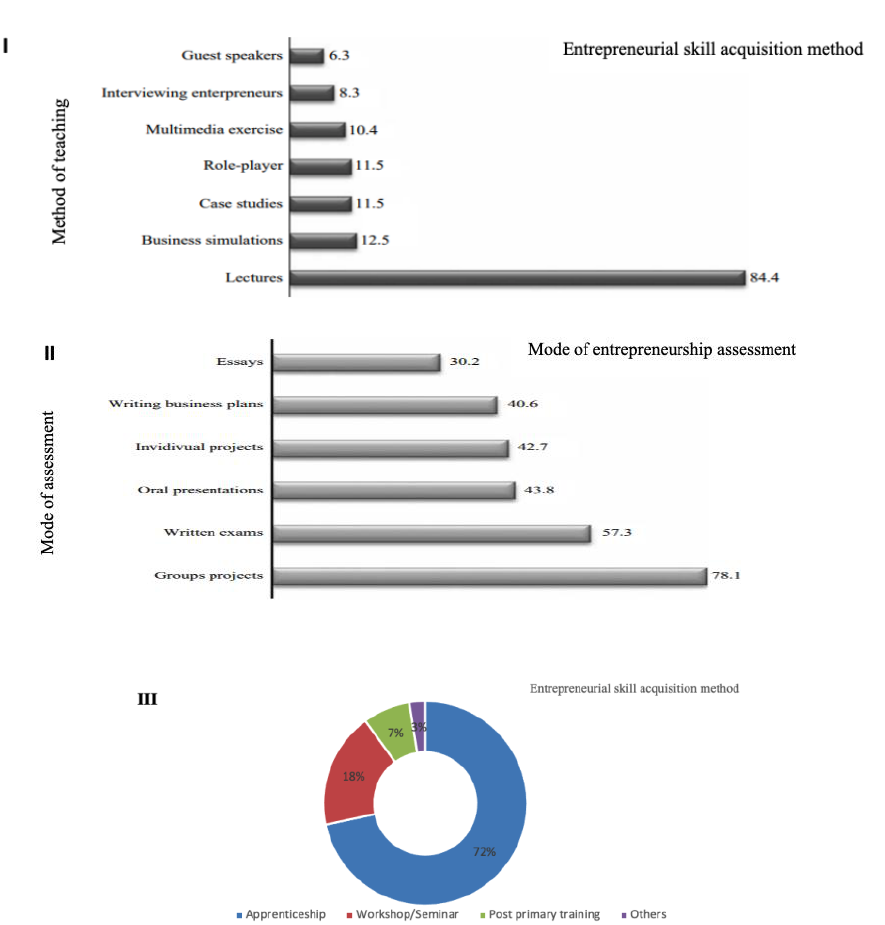
Figure 4: Methods of Imparting Entrepreneurial Skills and Modes of Assessment; (I) Method of Skill Acquisition (II) Mode of Assessment (III) Method of Skill Acquisition; Source : (Cheng et al., 2009; Ilemona et al.,